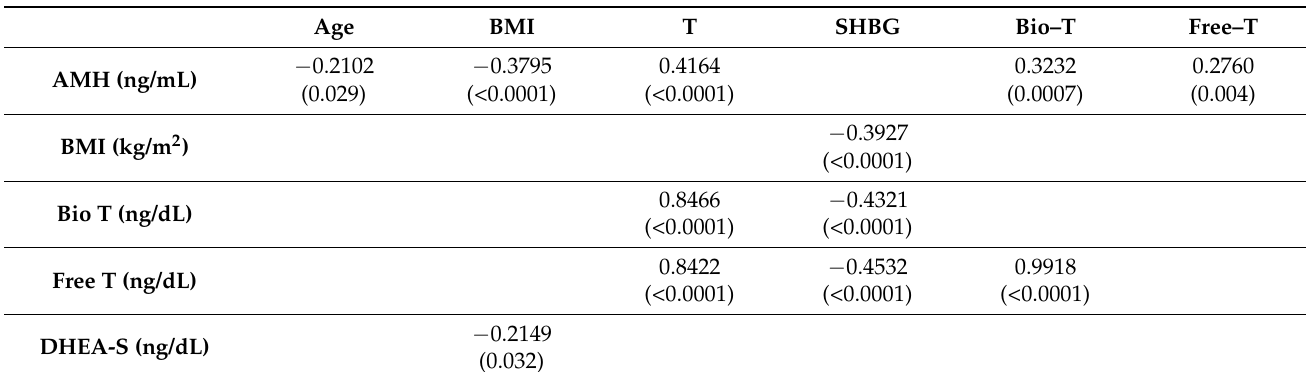
Table 3. Relationships among clinical, biochemical, and subjective variables of women with PCOS cance ( p < 0.05) are